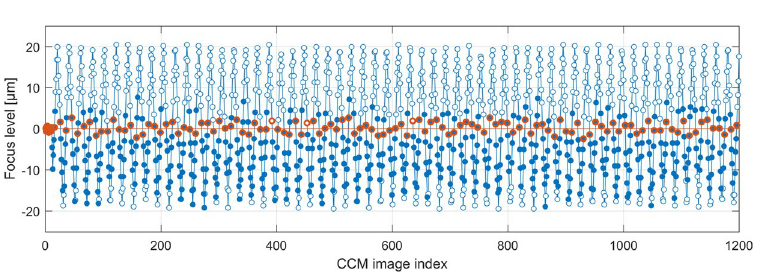
Figure 6. Plot of the focus levels of the CCM images (circles) of the dataset shown in Fig. 5. Red circles mark images acquired on the initial focus level. Solid circles mark CCM images classified as containing SNP tissue. These tend to lie below the initial focus level, and consequentially the M2 mosaic image in Fig. 5b tends towards showing epithelium